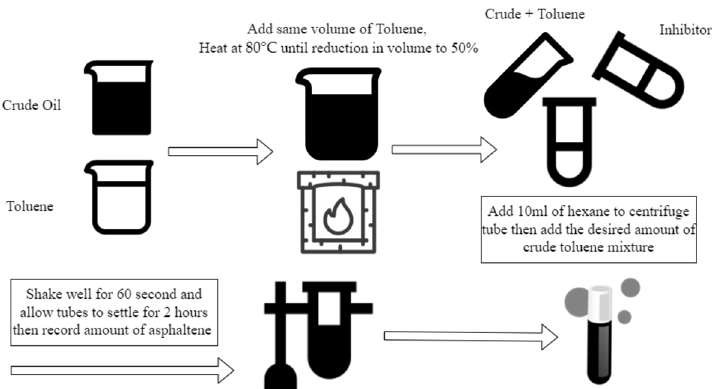
Figure 3. Asphaltene Dispersant Test